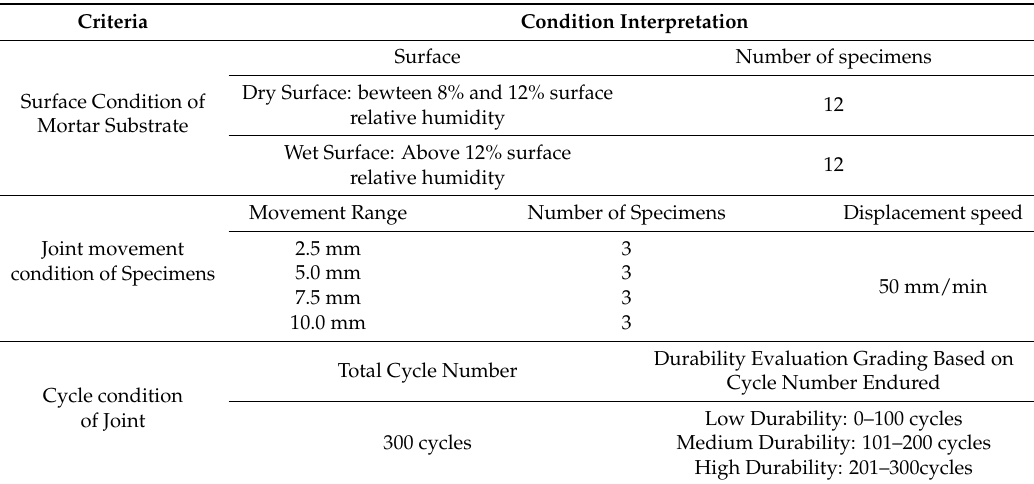
Table 7. Test specimen degradation evaluation criteria for concrete joint load behavior